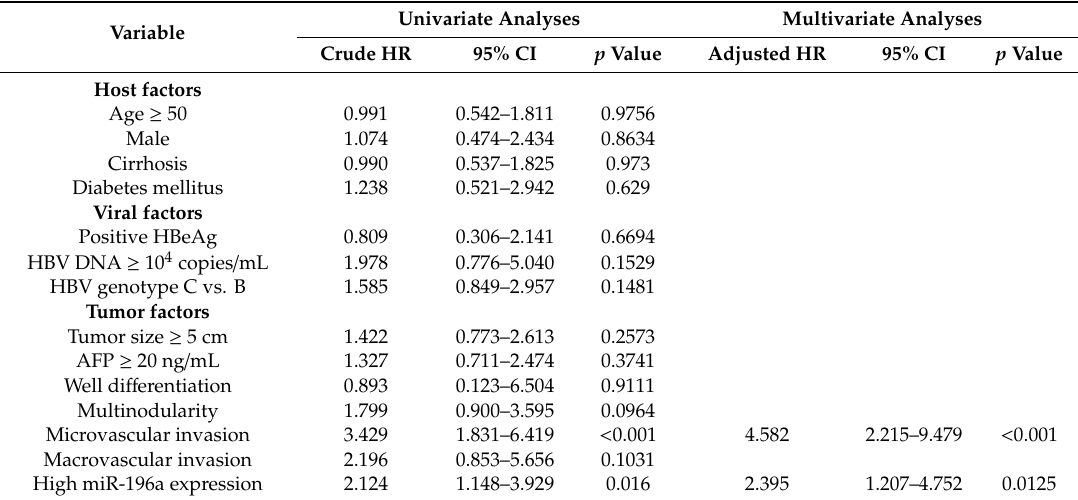
Table 2. Cox proportional hazard analyses for recurrence of hepatocellular